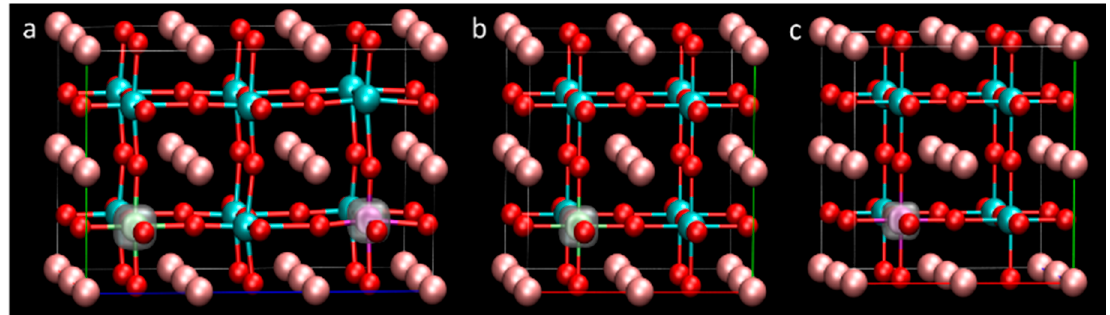
Figure 12. Partial charge-density distribution calculated from the top of the valence band to the bottom of the conduction band: ( a ) V and Cr co-doped BaTiO 3 ; ( b ) Cr-doped BaTiO 3 ; and ( c ) V-doped BaTiO 3 .